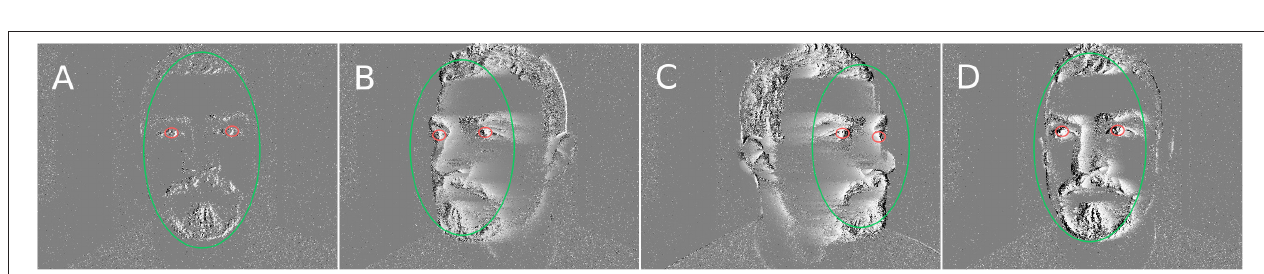
FIGURE 8 | Pose variation experiment. (A) Face tracker is initialized after blink. (B) Subject turns to the left. (C,D) One eye is occluded, but tracker is able to recover.